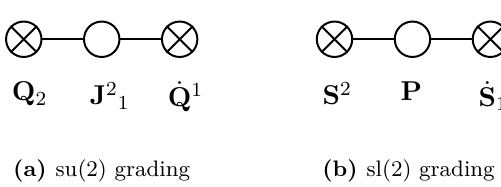
Figure 1. Two Dynkin diagrams for psu(1 , 1 | 2) with the simple roots indicated.